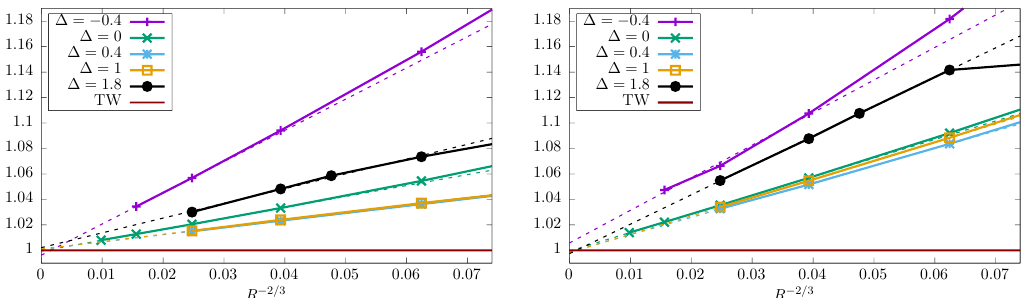
Figure 4: Left: skewness divided by the T-W one ( (cid:39) 0.224084). Right: excess kurtosis divided by the T-W one ( (cid:39) 0.093448). Both are shown as a function of R − 2 / 3 . As in the previous figure, extrapolation to a straight line shows nearly perfect